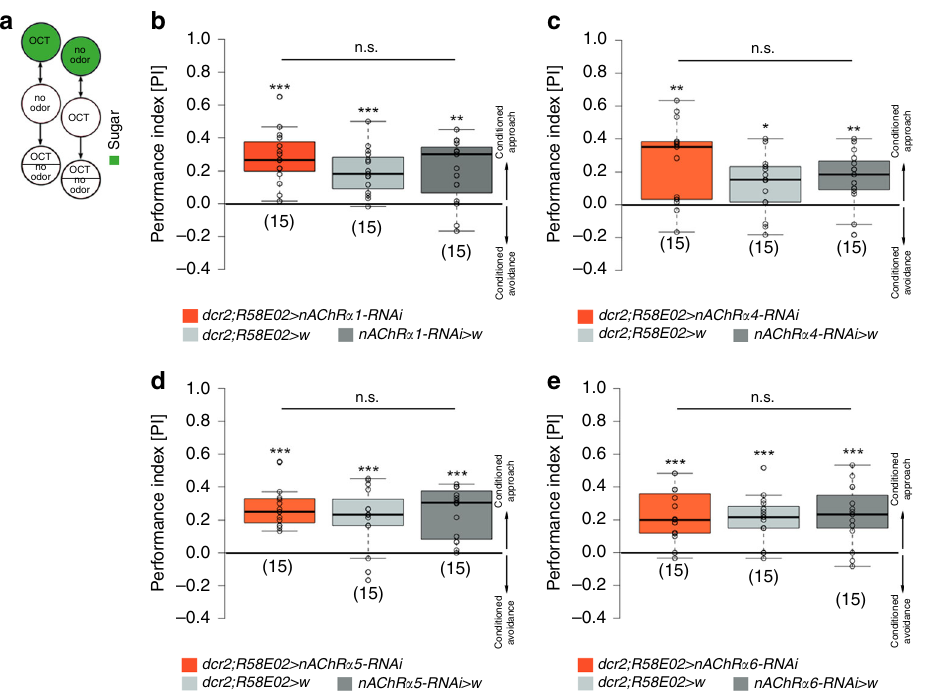
Fig. 5 KC-to-DAN feedback signaling is independent of ACh. a Illustration of the 1-odor reciprocal training regime used in this study (odor-sugar learning). b – e Speci fi c knockdown of acetylcholine receptor subunits α 1 ( b ), α 4 ( c ), α 5 ( d ), α 6 ( e ), respectively, in pPAM neurons does not affect odor-sugar learning. AChR: acetylcholine receptor; dcr2: dicer2; OCT: octanol; w: w 1118 . The number below the box plots refers to the N number. A pairwise Student ’ s t test or pairwise Wilcoxon test (both including Bonferroni-Holm correction) was used. Signi fi cance levels: n.s. p > 0.05, * p < 0.05, ** p < 0.01, *** p < 0.001. Data are mainly presented as box plots, with 50% of the values of a given genotype being located within the box, and whiskers represent the entire set of data. No data were excluded. Outliers are indicated as open circles. The median performance index is indicated as a thick line within the box